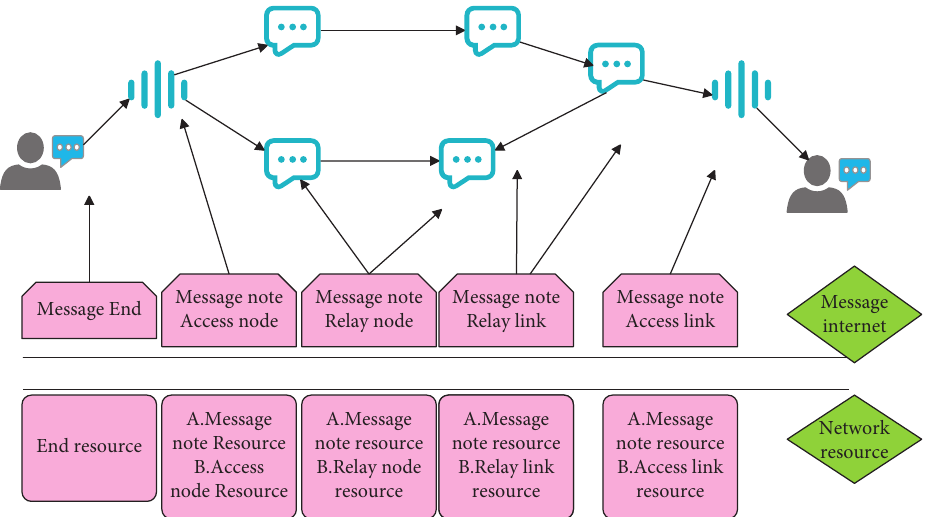
Figure 1: Schematic diagram of network composition and corresponding cognitive network project cost data decomposition.